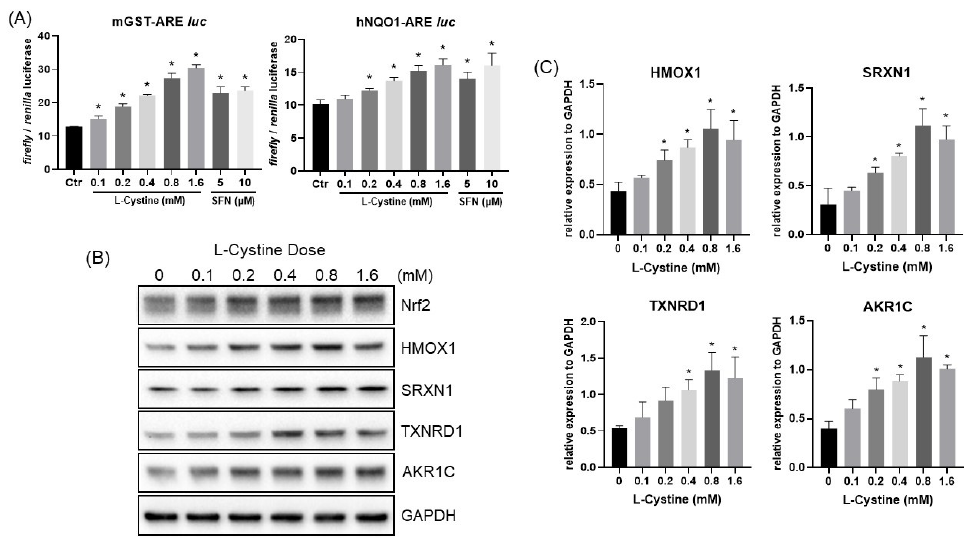
Figure 7. L-Cystine Dose Dependent Activation of ARE and Up-regulation of Nrf2 Downstream Genes at the Protein Level. HeLa cells were transfected with pGL4.37-mGST-ARE luc or pGL4.37-hNQO1-ARE luc vector together with pCMV of Renilla luciferase construct ( A ). At 48 h after transfection, cells were treated with various doses of L-Cystine or SFN as indicated for 16 h for measurements of luciferase activities. The data show means ± SD of the ratio of Firefly / Renilla luciferase from triplicate samples ( A ). Without transfection, HeLa cells were treated with L-Cystine at indicated doses for 16 h before harvesting to measure the levels of the proteins by Western Blot, using GAPDH as a loading control ( B ). Quantification of band intensities by NIH ImageJ was shown as means ± SD from three independent experiments ( C ). * indicates statistically significant compared to the control as the adjusted p value < 0.05 by one-way ANOVA, corrected by Dunnett’s multiple comparisons test ( A , C